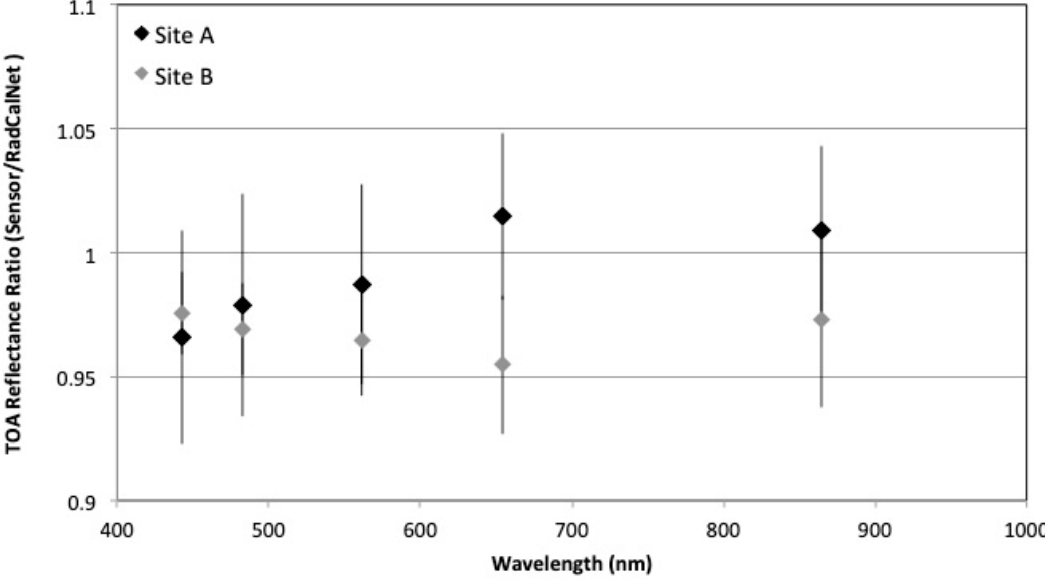
Figure 8. Average ratio of RadCalNet predicted TOA reflectance to that reported by Sensor #1 for Sites A and B. Uncertainty bars are based on the standard deviation of the averages from the seven dates for Site B and the 10 dates for Site A.